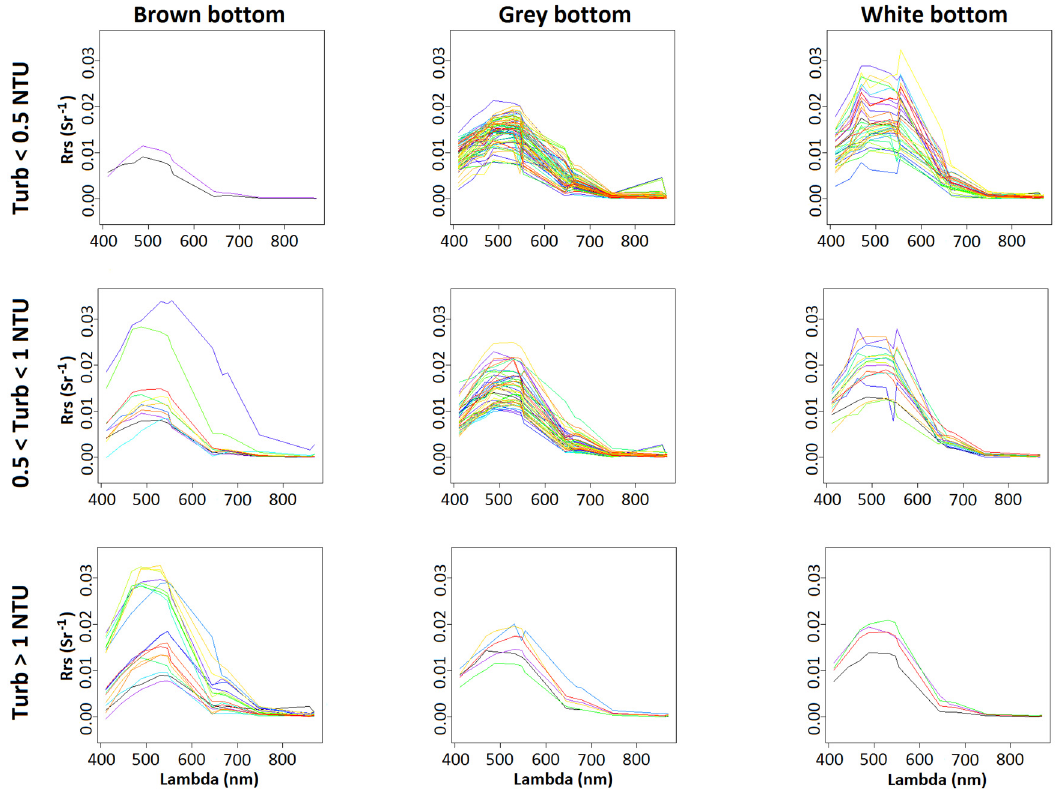
Figure 9. Spectra of MODIS reflectance on all pixels used for the construction of our SVR model and classified by both turbidity values (i.e., Upper row: Turb < 0.5 NTU, Middle row: 0.5 < Turb < 1, Lower row: Turb > 1) and bottom colour (i.e., Left: Brown bottom, Middle: Grey bottom, Right: White bottom).